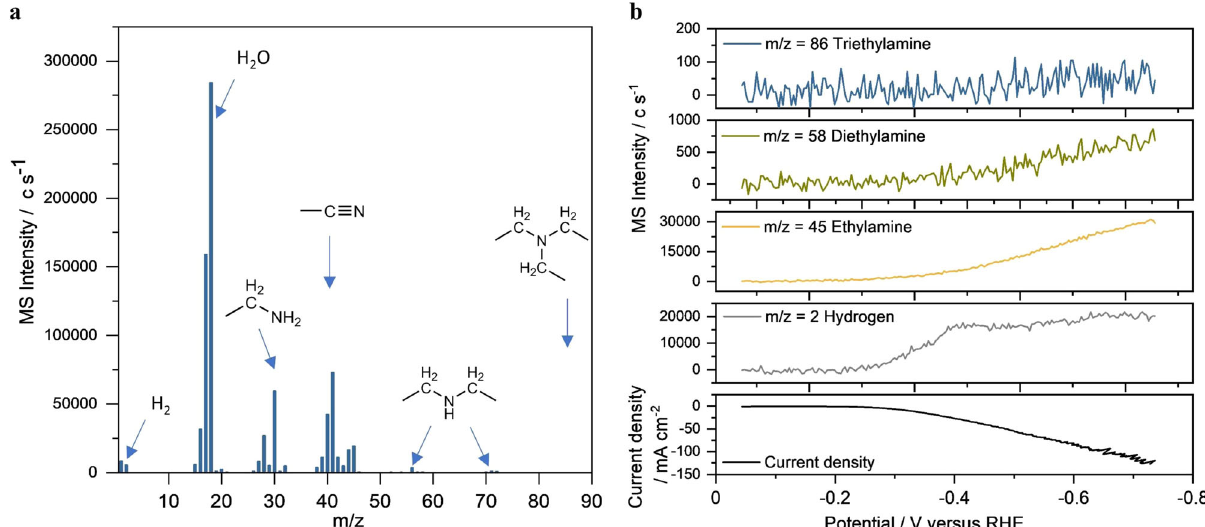
Fig. 4 The product distribution analysis by fl ow electrolyzer mass spectroscopy (FEMS). a Mass spectrometric signals recorded while scanning in a mass range of 0 − 90 amu at − 0.5 V versus RHE. b Linear sweep voltammetry measurement ranging from 0 V to − 0.76 V versus RHE (scan rate of − 5 mV s − 1 ). The potentiostat signal (black line) was synchronized with the fragment intensity of hydrogen (gray line), ethylamine (orange line), diethylamine (green line), and triethylamine (blue line) recorded in a mass spectrometer. The m/z stands for mass-to-charge ratio.